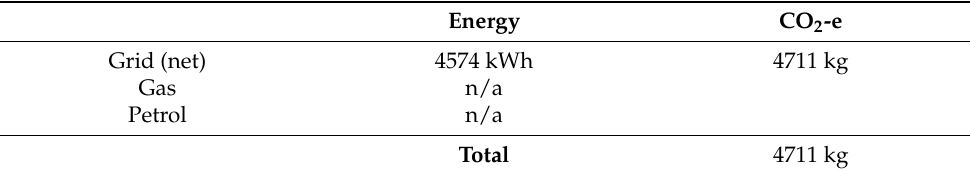
Table 5. House 3: CO 2 equivalent emissions (2018).